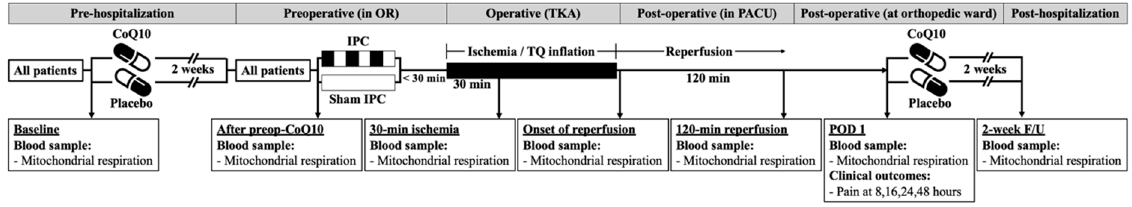
Figure 1. Study flow demonstrating patient allocation, study protocols, and outcome measure- ments.